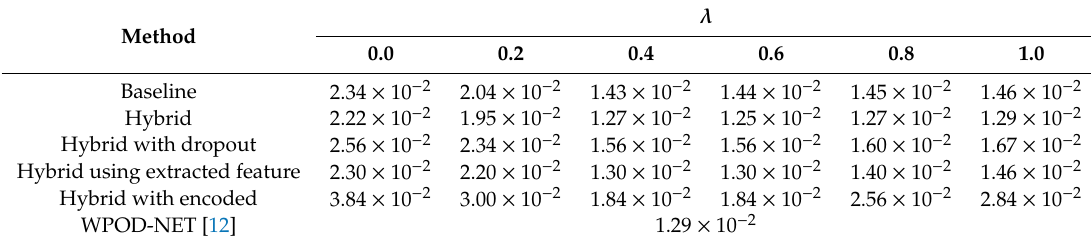
Table 1. The average di ff erences of normalized predicted coordinates from ground truth. The models trained with the loss function with di ff erent λ were